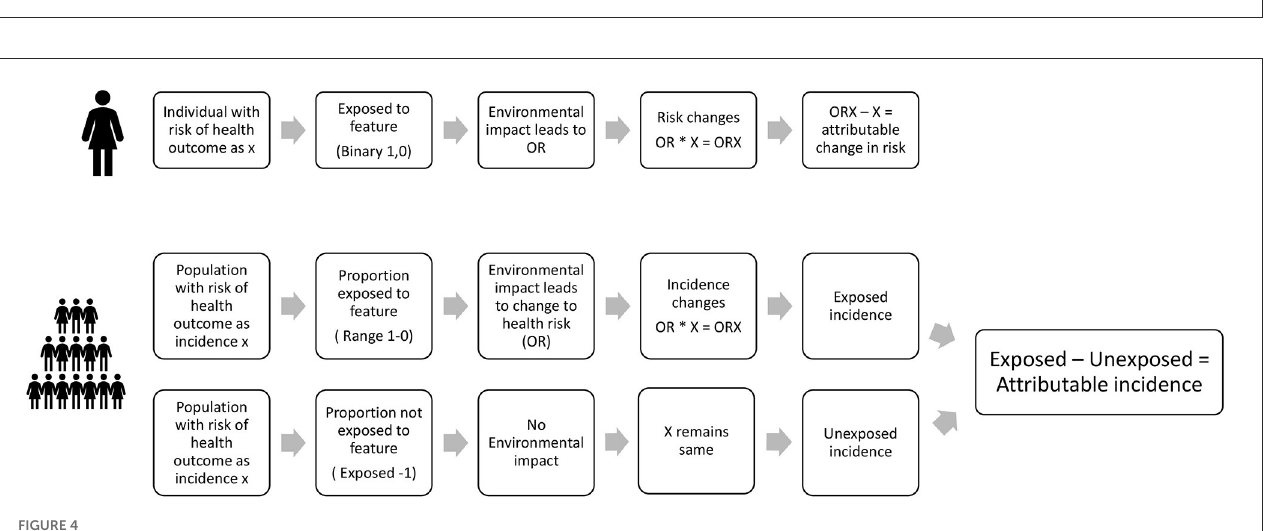
FIGURE3 Illustration of the structure of the Health Appraisal for Urban Systems (HAUS) tool.